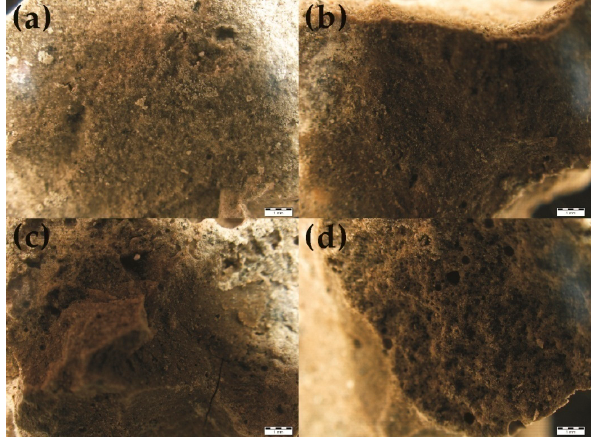
Figure 10. Images observed by a polarizing microscope of 200 °C-heated specimens: ( a ) control; ( b ) AAC with 3% CS; ( c ) AAC with 3% HPS; ( d ) AAC with 3% CMS.